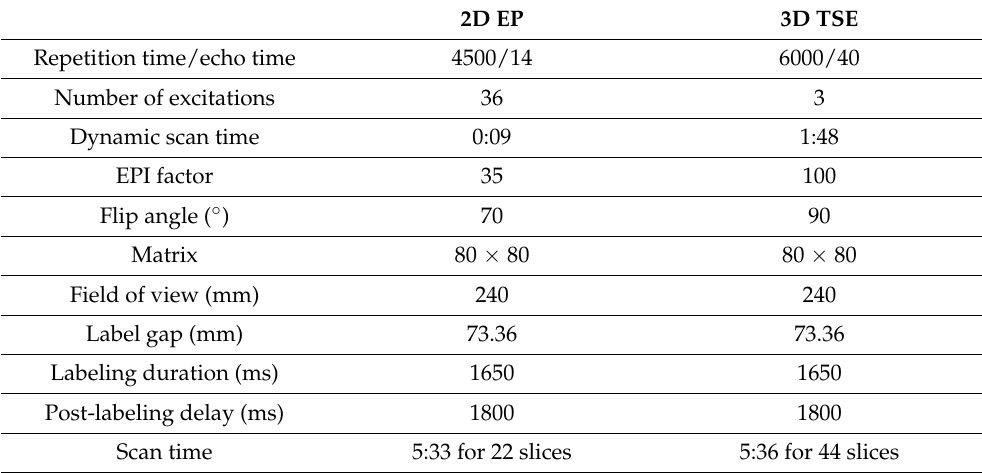
Table 1. pCASL imaging protocol.